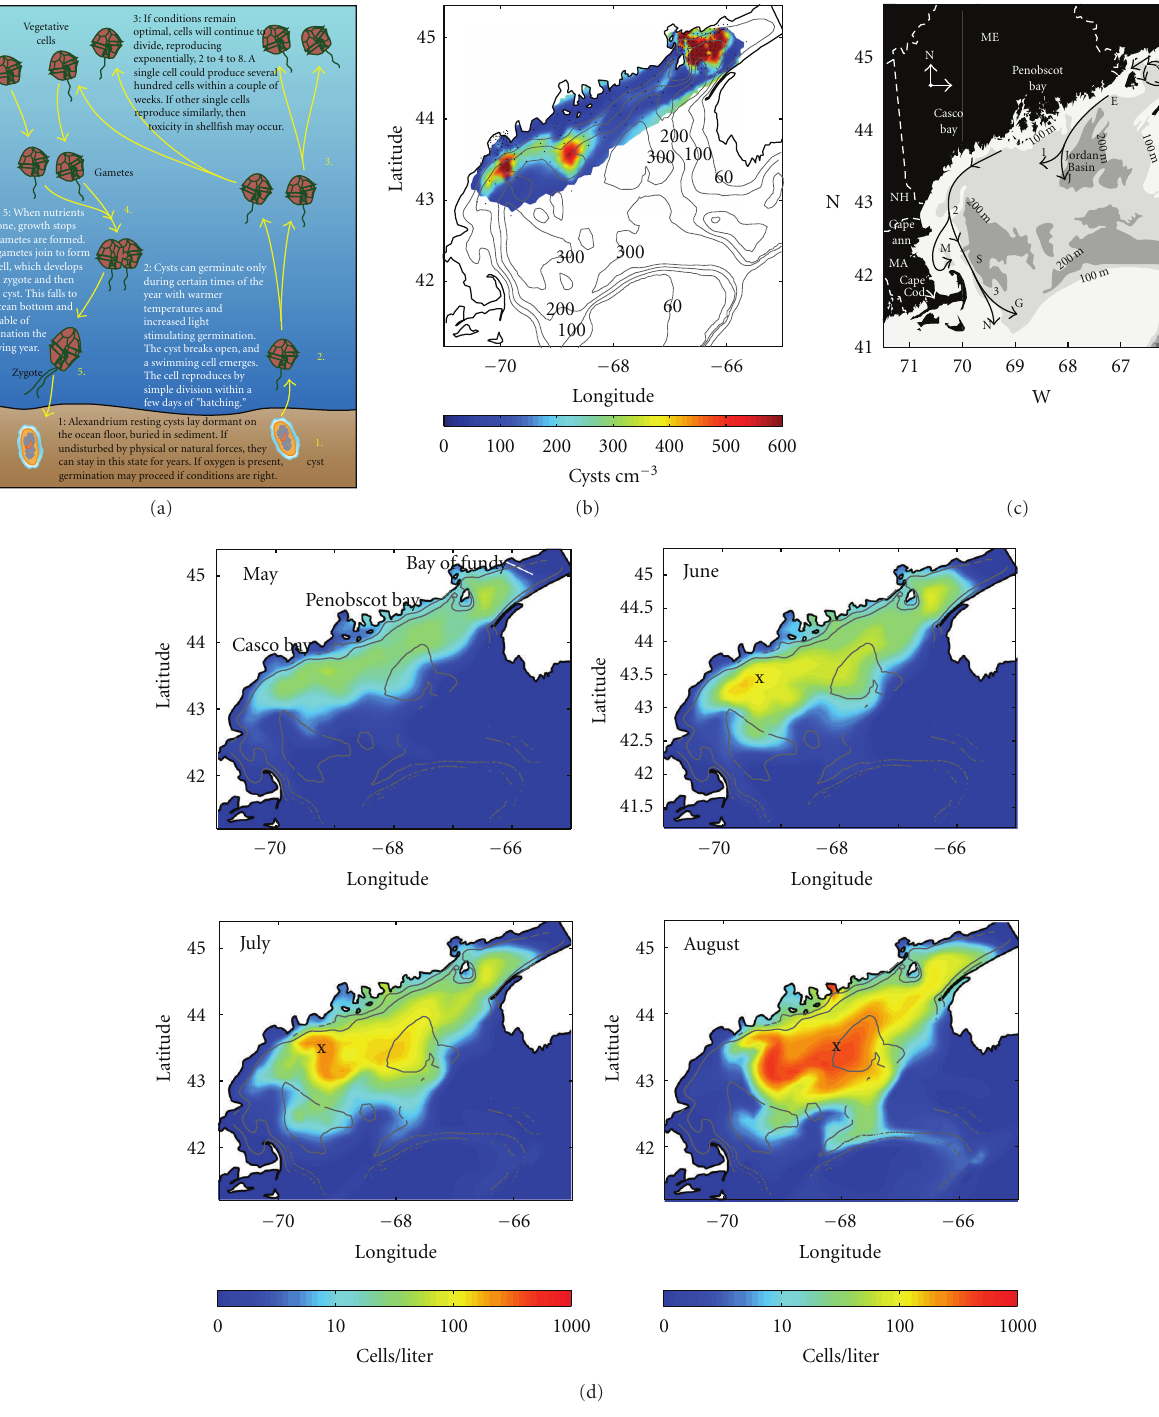
Figure 2: Upper left: life cycle of A. fundyense . Upper middle: distribution of cysts (number of cysts cm − 3 ) in the upper 3cm of sediment derived from a 1997 survey of the Gulf of Maine [98] and surveys of the Bay of Fundy in 1981 (White and Lewis, 1982), 1982, and 1983 (data provided by Jennifer Martin, DFO). Upper right: schematic of the Maine Coastal Current, reprinted from McGillicuddy et al. [99]. Branch points are located at (1) Penobscot Bay, (2) Cape Ann, and (3) Great South Channel. Seven segments of the current are indicated: (E)astern, (J)ordan, (W)estern, (M)assachusetts, (S)tellwagen, (N)antucket, and (G)eorges Bank. Dashed white lines denote state boundaries of Maine (ME), New Hampshire (NH), and Massachusetts (MA). From Backer and McGillicuddy [100]. Reprinted with permission from Oceanography